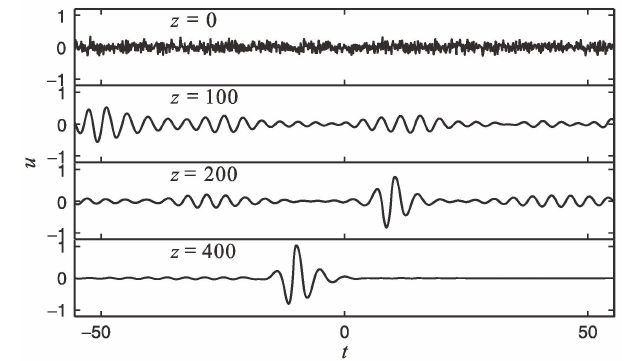
Figure 8: Modeling the self-starting of a mode-locked laser with SPE. (Adapted from